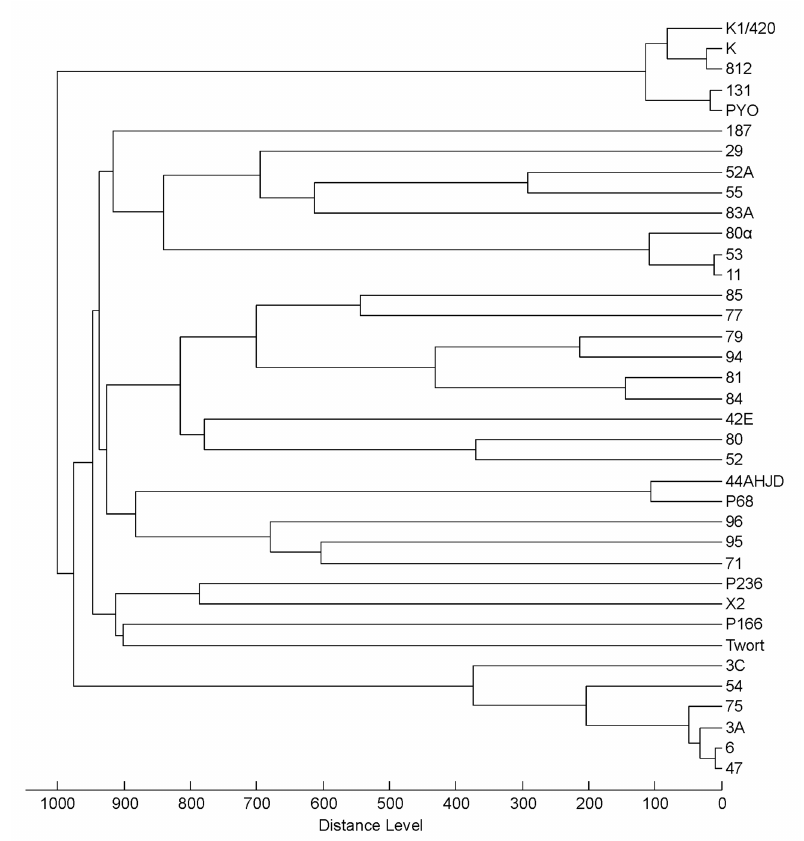
Figure 5. Cluster analysis of mass spectra of all 37 phage strains involved in the study.